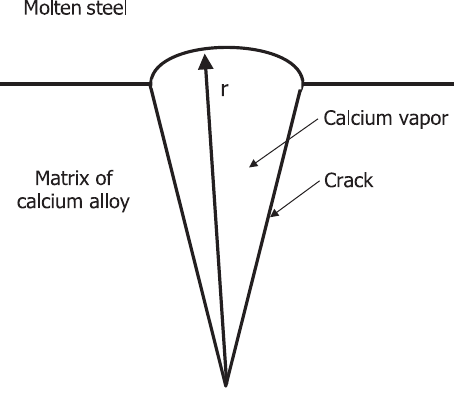
Fig. 10: Schematic illustration of a nucleation site for calcium vapor at a surface crack of the calcium